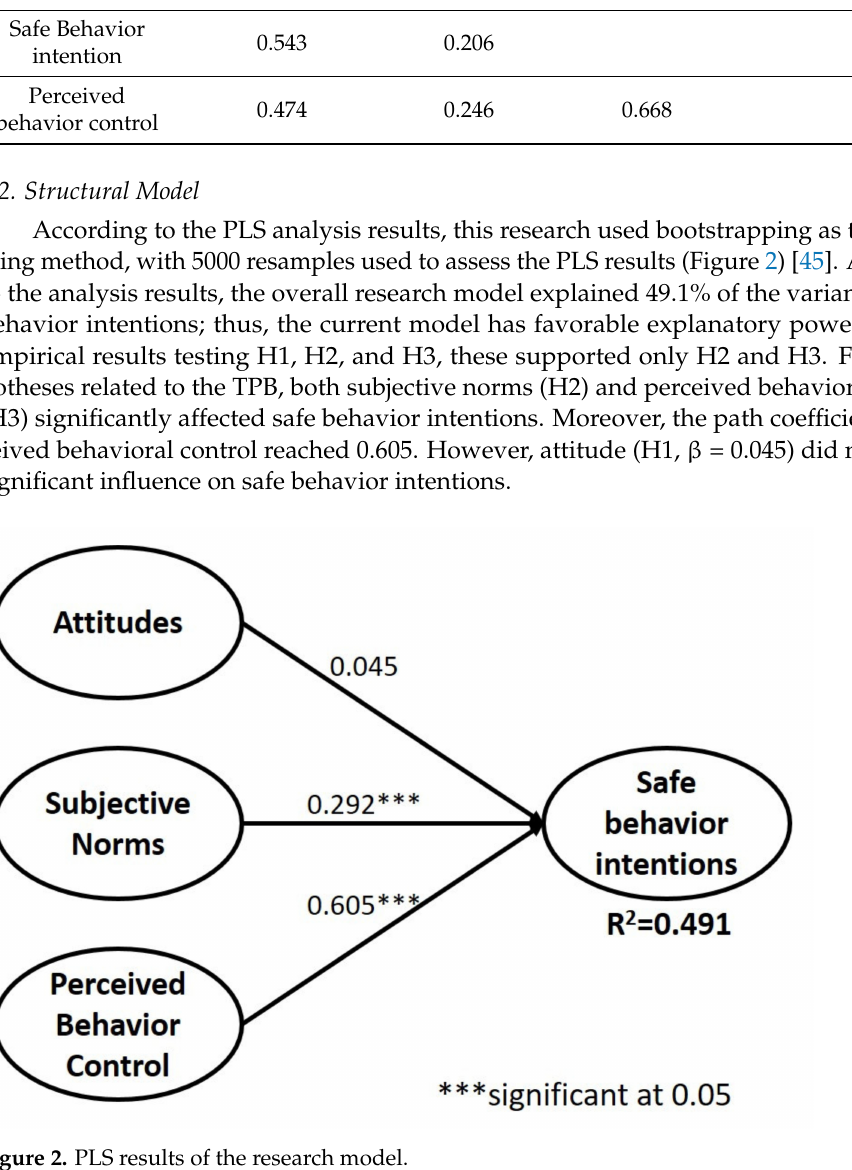
Figure 2. PLS results of the research